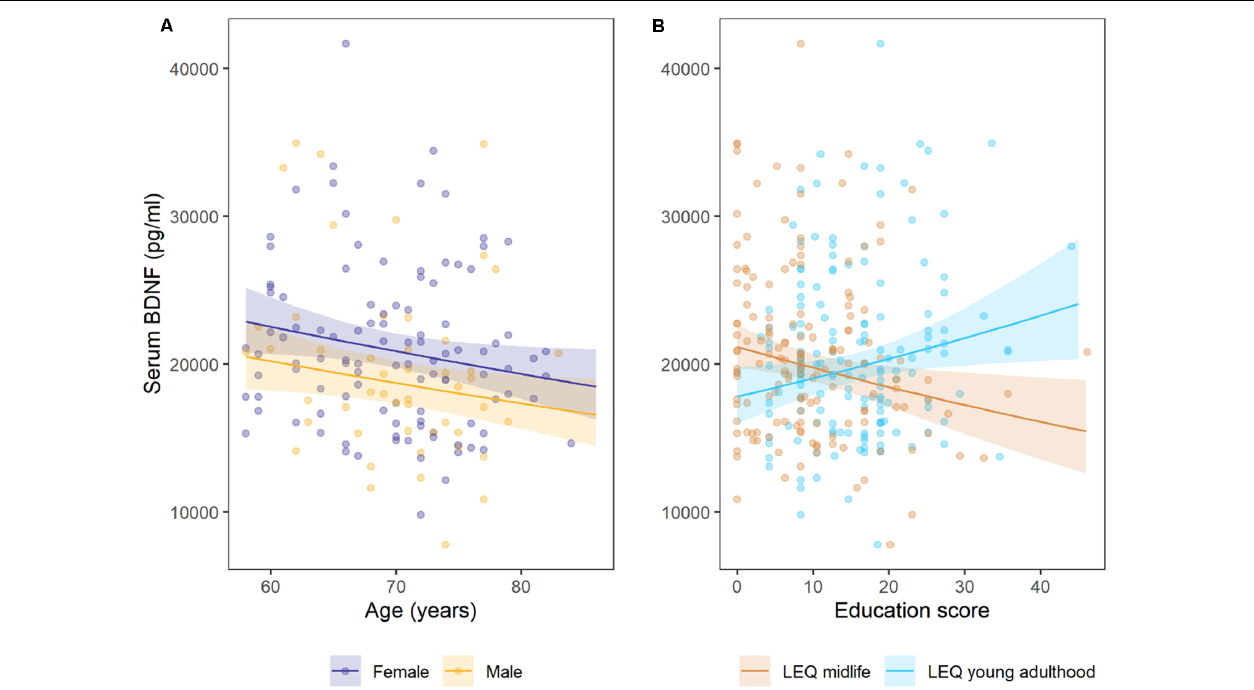
FIGURE 1 | Estimated marginal mean trends for (A) age stratified by gender, (B) lifetime of experiences questionnaire (LEQ) midlife education and LEQ young adulthood education. Points are observed data, shaded regions represent 95% confidence intervals. Females had small, but significantly higher mean (log) serum BDNF than males, and concentrations decreased with each year of age (in adults older than 58 years of age). Cross-sectional serum BDNF concentrations increased with higher young adulthood education and training scores, but decreased with higher mid-life education and training scores on the